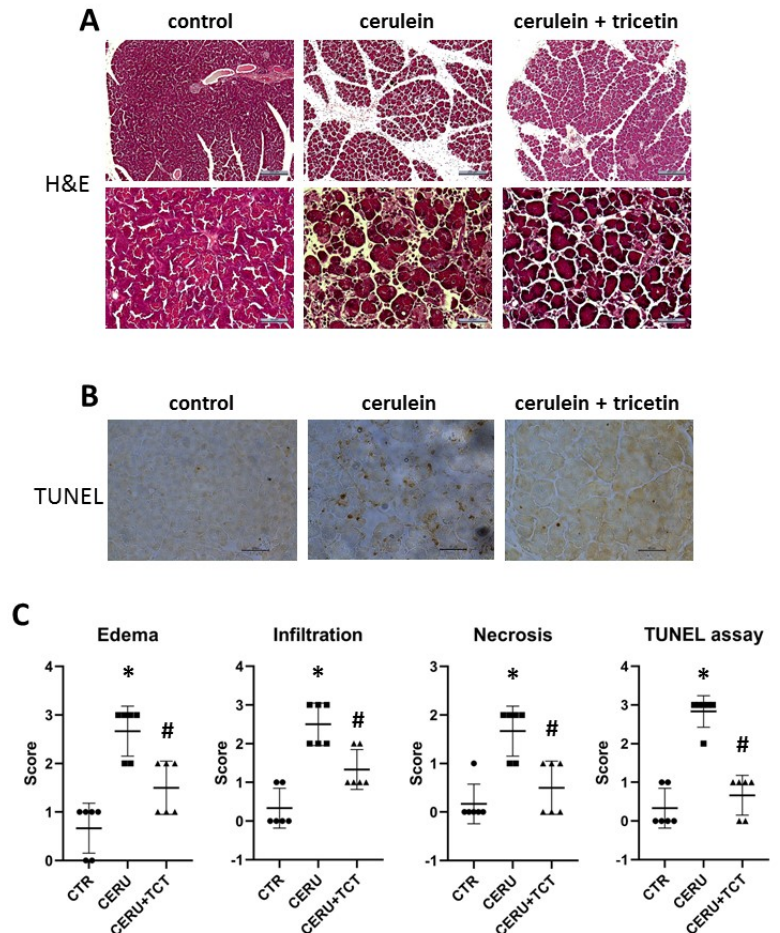
Figure 5. Tricetin inhibits tissue injury, edema, apoptosis, and necrosis in acute pancreatitis. Micro- graphs of hematoxylin and eosin-stained pancreas sections from mice treated with saline, cerulein, or cerulein + tricetin (TCT) (scale bar in the top row is 200 μ m and in the bottom row is 50 μ m) ( A ). Micrographs of pancreas sections stained for TUNEL assay from the same three groups of mice (scale bar is 50 μ m) ( B ). Edema, leukocyte infiltration, apoptosis (TUNEL assay), and necrosis scores (0–3) were determined by a pathologist ( C ). Error bars represent SD of six mice. Statistical analysis was performed with Fisher’s exact test. Stars (*) indicate significant ( p < 0.05) differences between cerulein-treated and control groups. Hashtags (#) indicate significantly ( p < 0.05) reduced scores in the TCT group versus the cerulein-treated group.